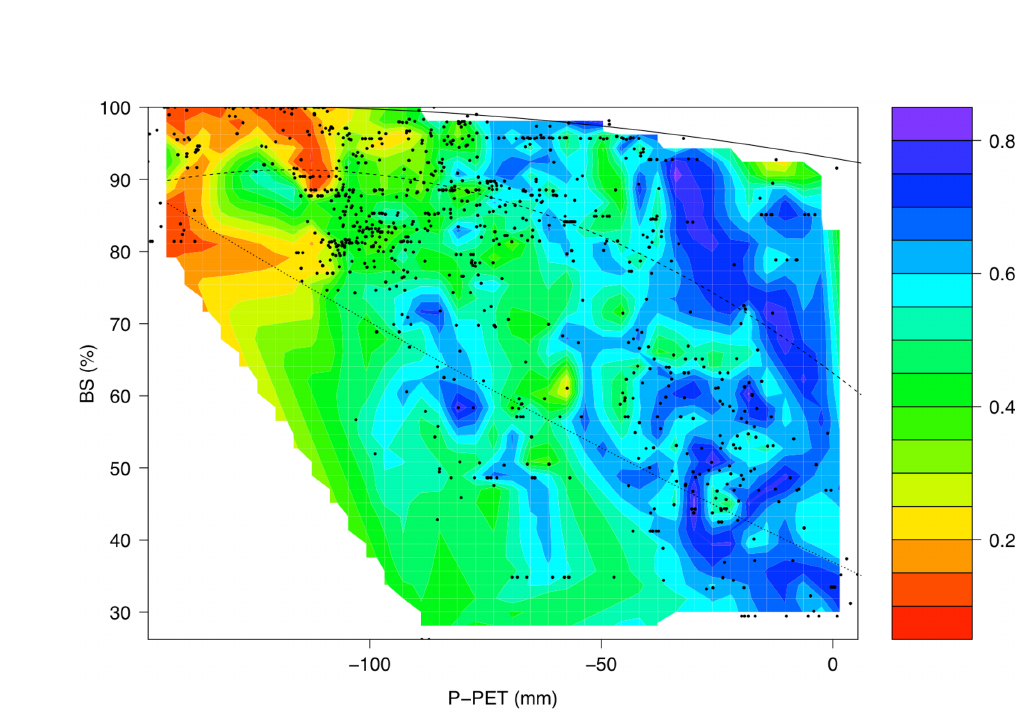
PLOS ONE | DOI:10.1371/journal.pone.0144512 December 9,